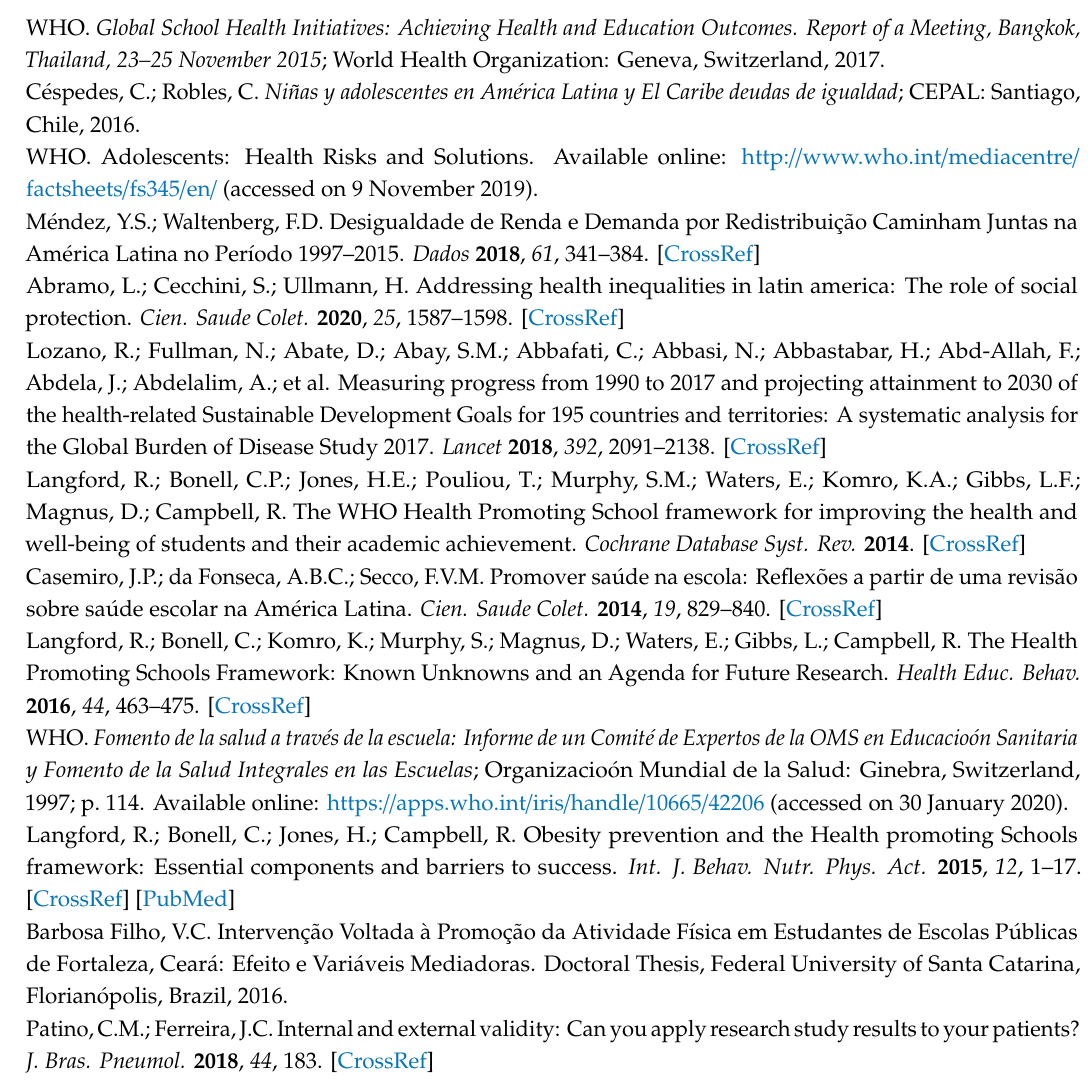
Table S1: Prisma-P Check List. Table S2: Example of search terms, which will be used at Medline / Pubmed. Table S3: Example of search terms, which will be used at Lilacs, Scielo, BTDT and ReBEC. Table S4: Characteristics to be extracted related to implementation. Table S5: Characteristics to be extracted related to